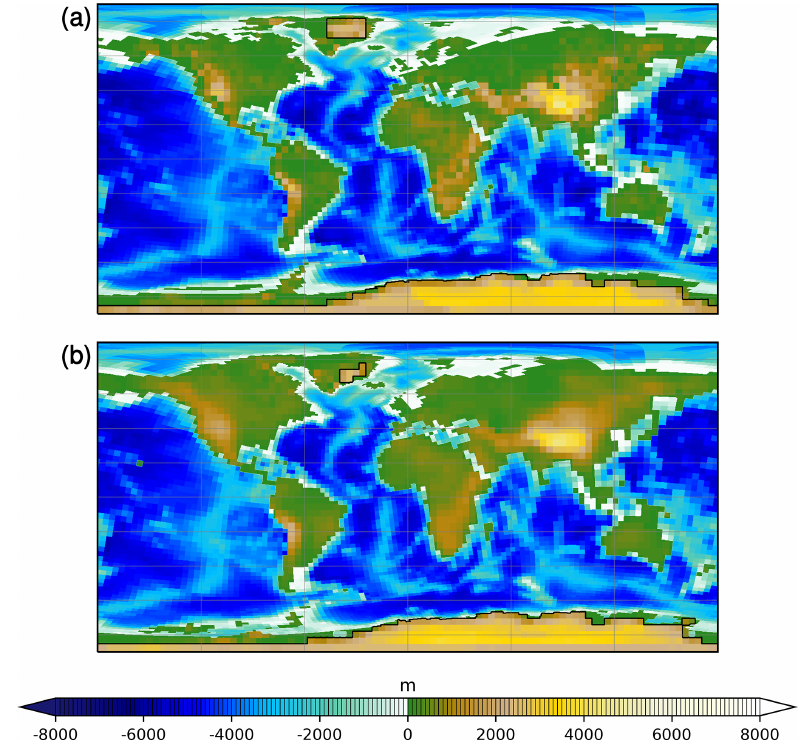
Figure 1. (a) PRISM3D land–sea mask implemented in COSMOS simulations for PlioMIP1 based on data provided by Haywood et al. (2010), assuming the presence of an open Bering Strait and Canadian Arctic Archipelago. (b) PRISM4 land–sea mask implemented in COSMOS simulations for PlioMIP2 with a closed Bering Strait and Canadian Arctic Archipelago as described in the PlioMIP2 protocol (Haywood et al., 2016; Dowsett et al., 2016). Color shading depicts the prescribed land orography and ocean bathymetry (m) for PlioMIP1 and PlioMIP2, respectively. Black isolines depict prescribed mid-Pliocene ice sheets for the respective phases of PlioMIP. Differences over Antarctica are due to the switch from employing a modern land–sea mask with minor modifications towards Pliocene conditions in the COSMOS PlioMIP1 simulation and employing a full Pliocene representation of Antarctic geography in COSMOS for